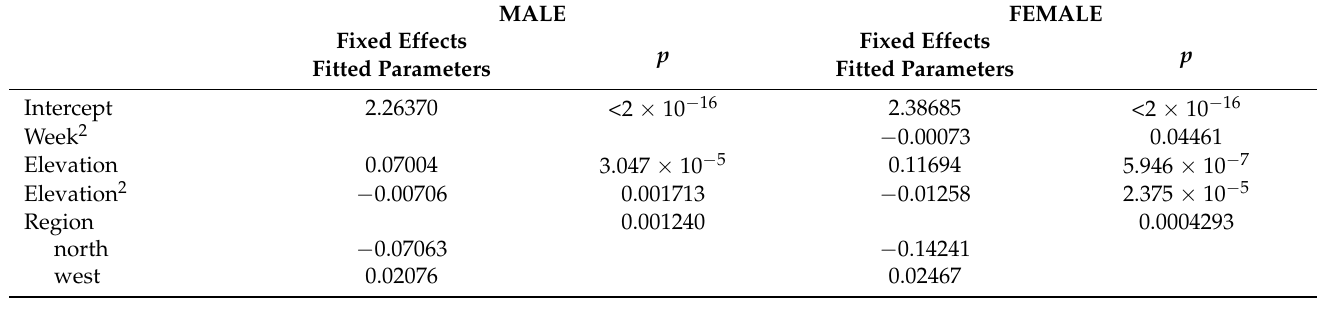
Table 4. Explaining intraspecific size variation of a New Zealand mayfly. Linear mixed effects model for log wing length in male (left) and female (right) Acanthophlebia following model simplification by stepwise removal of non-significant terms. p -values are from type III anova and Satterthwaite’s method for approximating degrees of freedom.